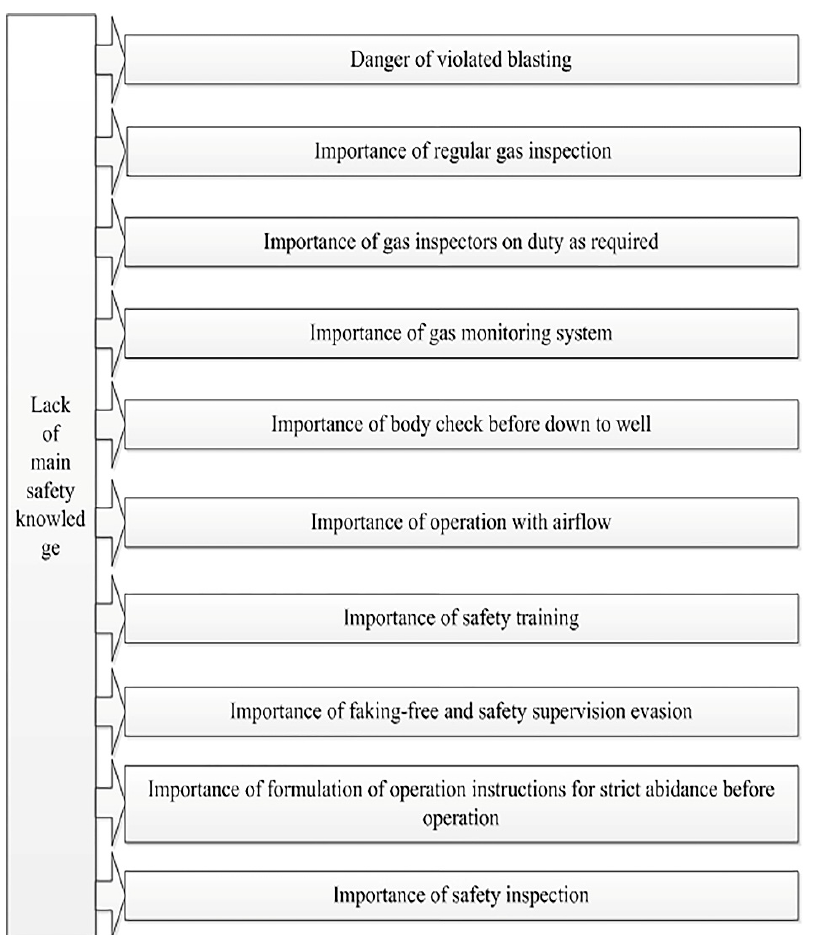
Figure 7. Main safety knowledge deficiencies manifested by employees.